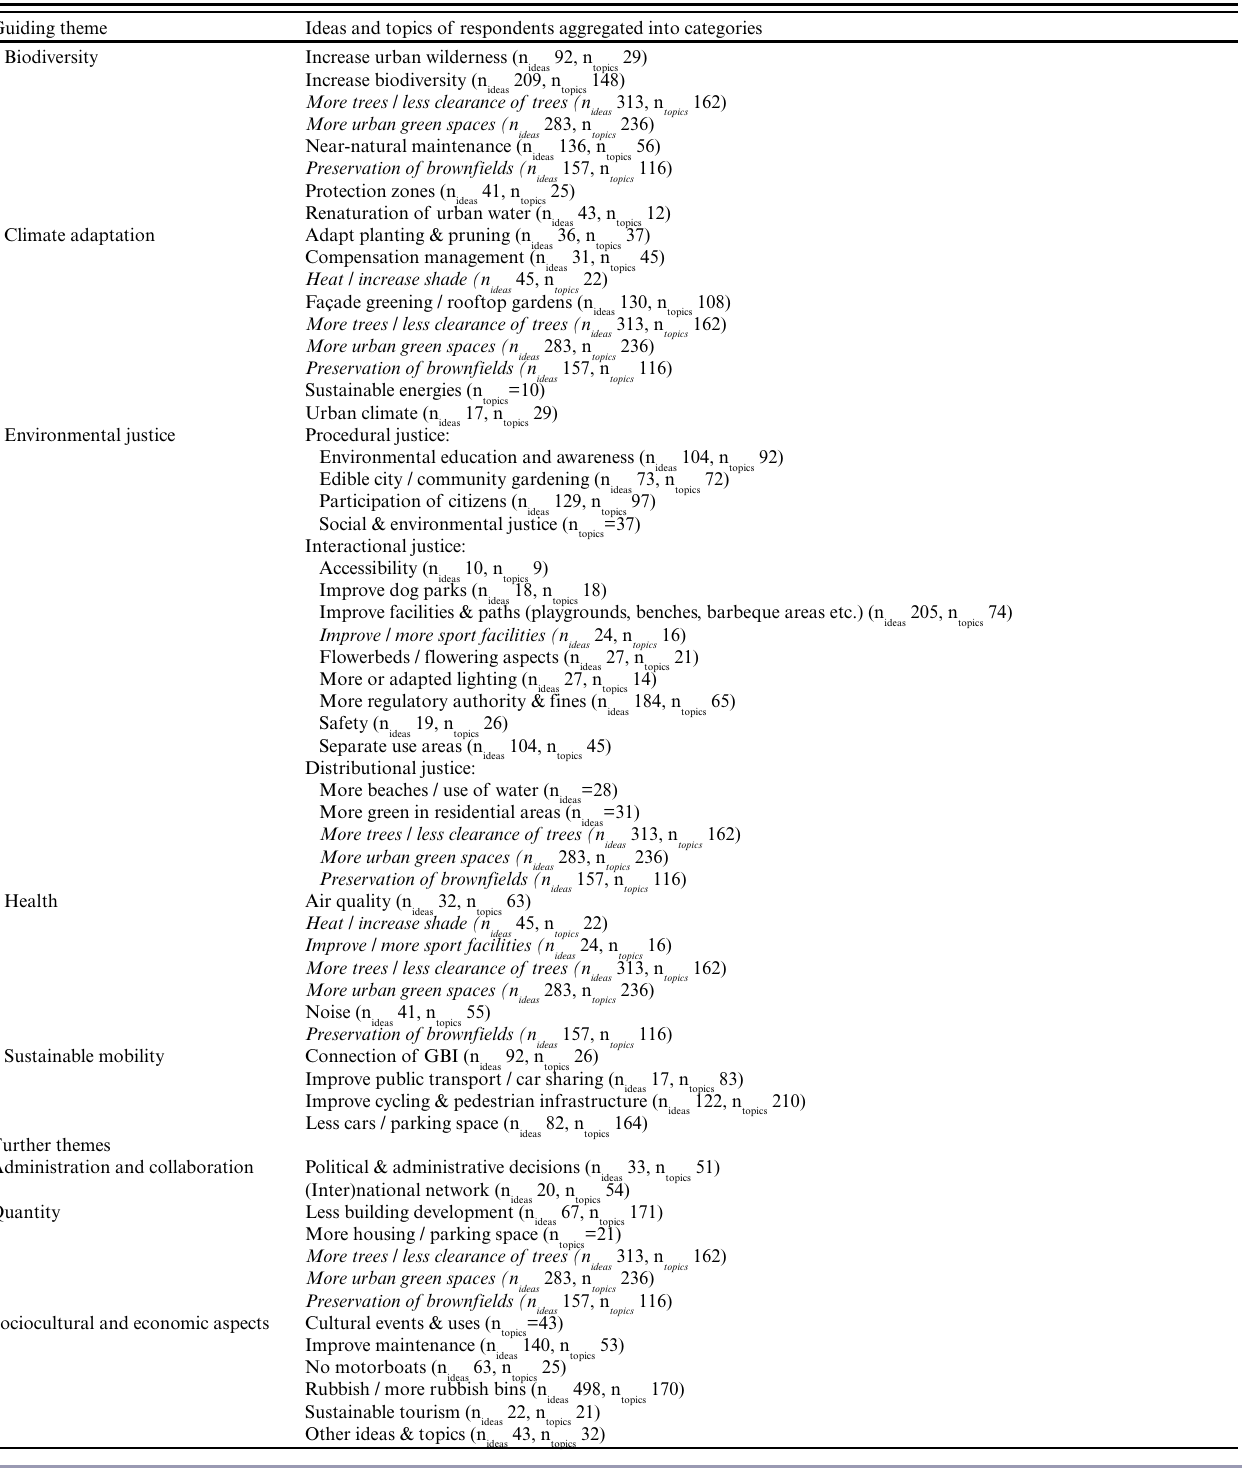
Table 1 . Allocation of aggregated categories of citizens’ ideas (n = 3808) and important topics (n = 2917) to the five guiding themes of the Master Plan Green. Some categories that were allocated to more than one guiding theme are marked in italics. Guiding theme Ideas and topics of respondents aggregated into